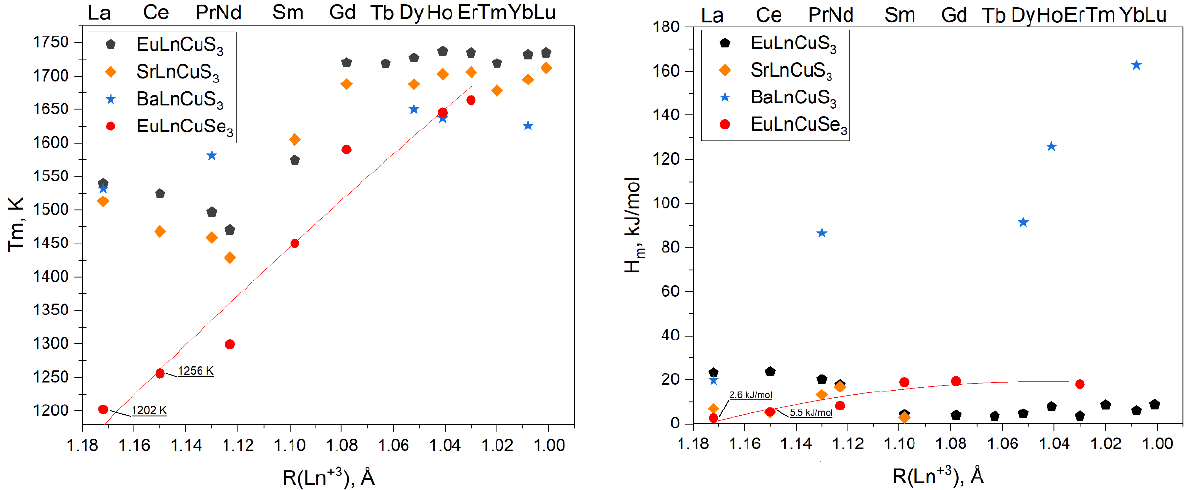
Figure 8. SEM/EDS patterns of the sample surface cooled from 1435 °C. Phase designation: 1-EuSe, 2-Eu 1 − x − y Er x Cu y Se, 3-eutectic formed by phases Eu 1 − x Er x Cu y Se and Cu 2 − x Se, 4-EuErCuSe 3 , 5-Er 2 Se 3 . Distribution maps of the chemical elements in a EuErCuSe 3 sample cooled after DSC (1708 K). Table 4. Temperature (K) and phase transition enthalpy (kJ mol 1 ) values in the EuErCuSe 3 com- pound.